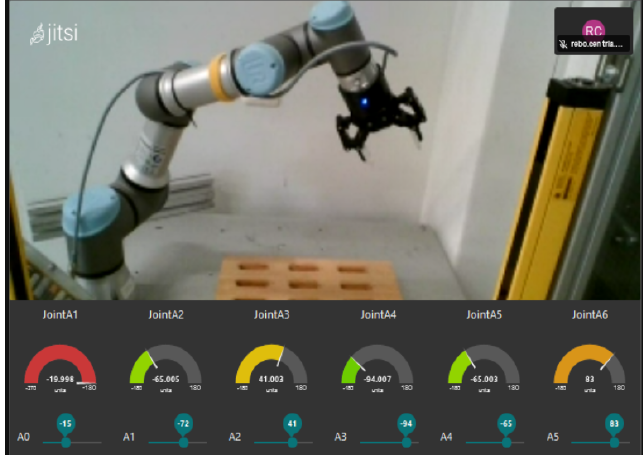
Figure 5. Control interface of collaborative robot with embedded live